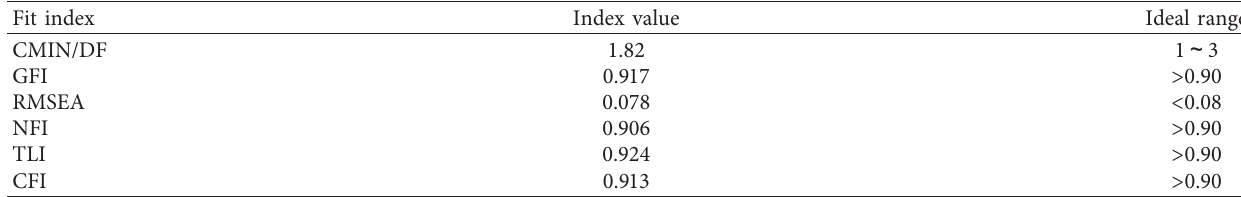
Table 6: Fit statistics of causal analysis model between